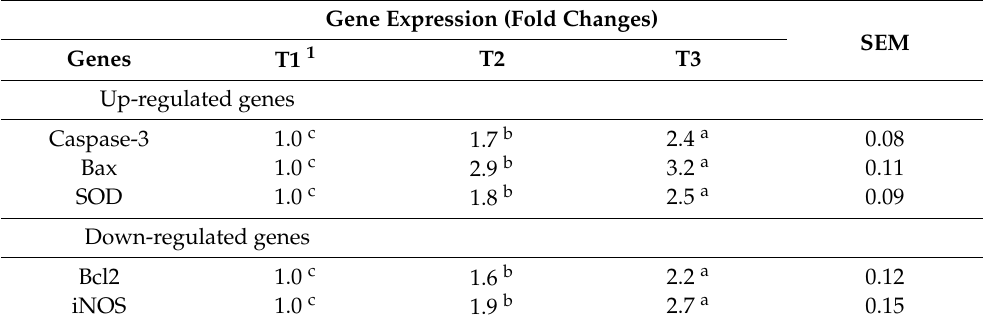
Table 6. Alterations in the expression of apoptosis related genes in mice colon tissue under different treatments.